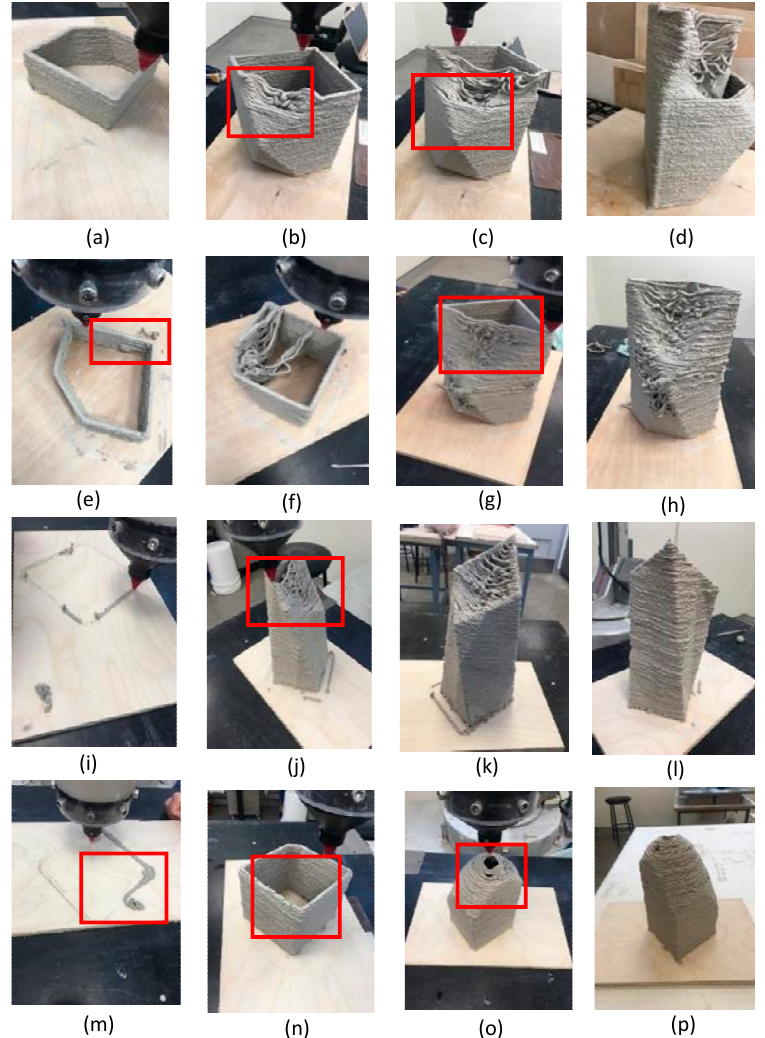
Figure 8. Architecture models made of paper clay: ( a – d ) Model 1 100%; ( e – h ) Model 2 100%; ( i – l ) Model 3 100%; ( m – p ) Model 4 100% (source: authors). Table 7. Summary of criteria discussed in the literature and examples from the sample.